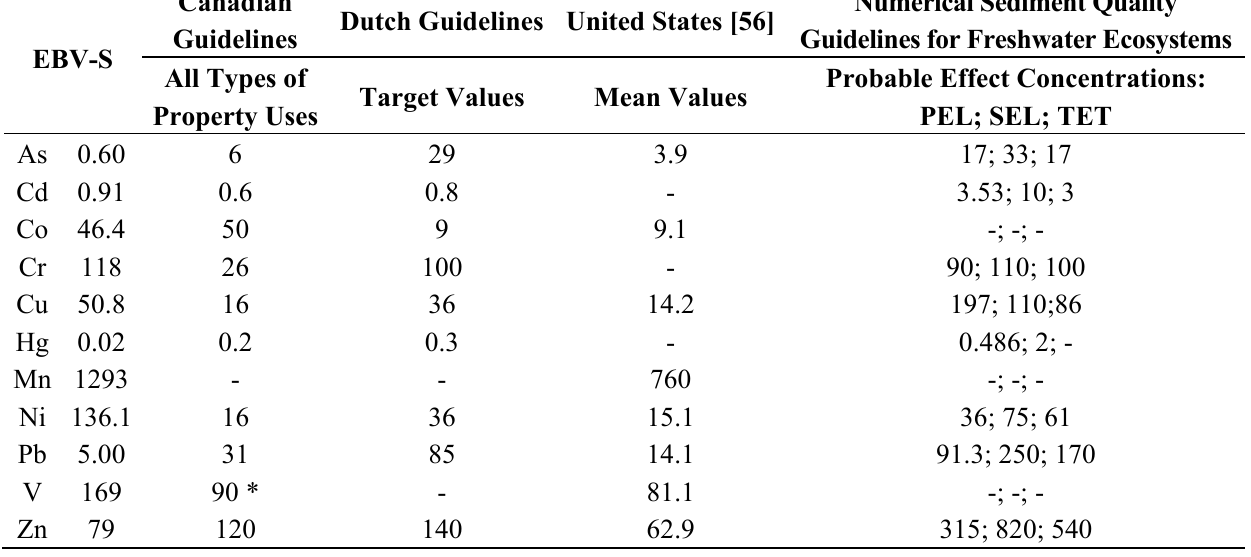
Table 4. Estimated Background Values of harmful elements from the stream sediments of Santiago (EBV-S), admissible levels (in mg ∙ kg −1 ) in stream sediments according to the Ontario, Dutch and United States guidelines, and the numerical sediment quality guidelines for freshwater, including their probable effect concentrations